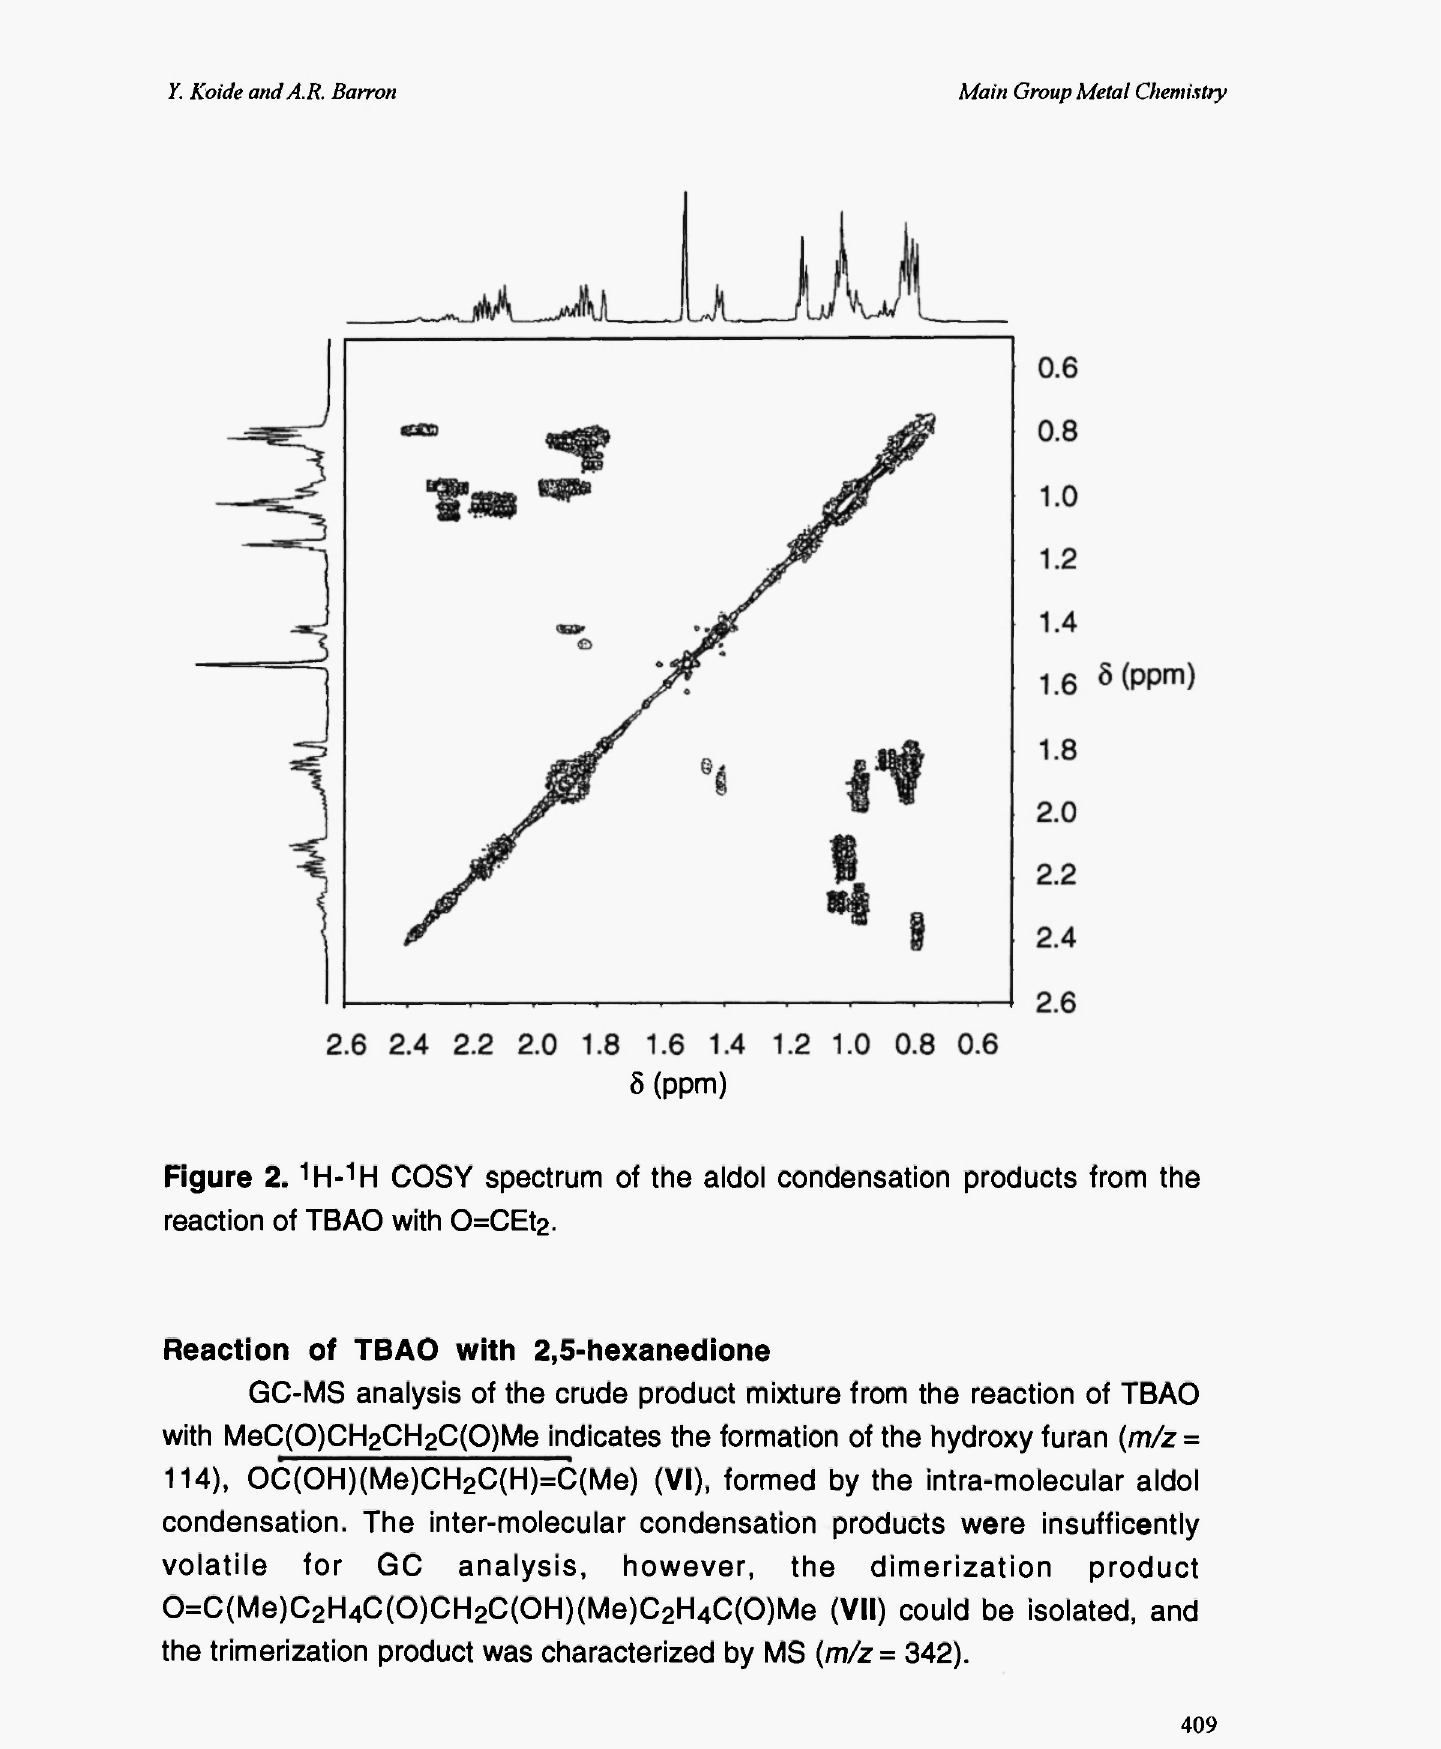
Figure 2. 1 H- 1 H COSY spectrum of the aldol condensation products from the reaction of TBAO with 0=CEt2-